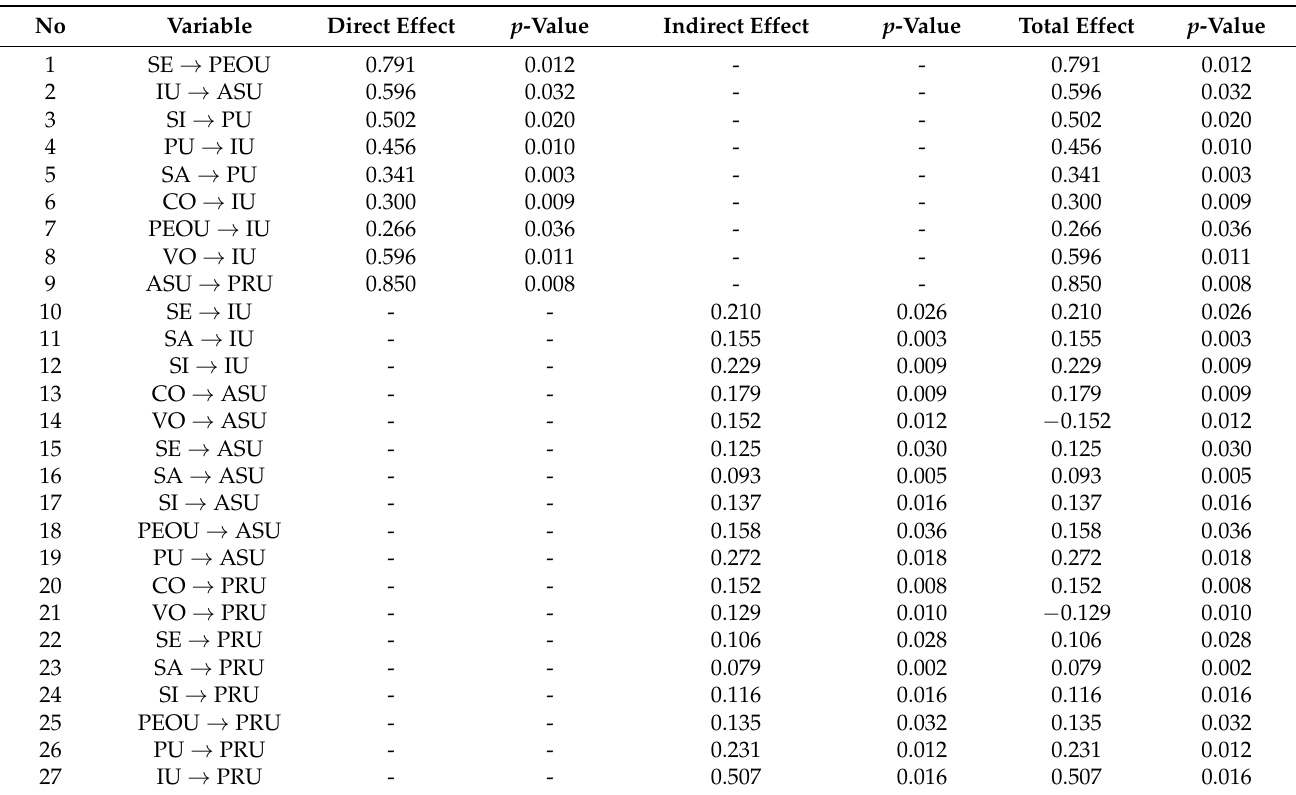
Table 5. Direct, indirect, and total